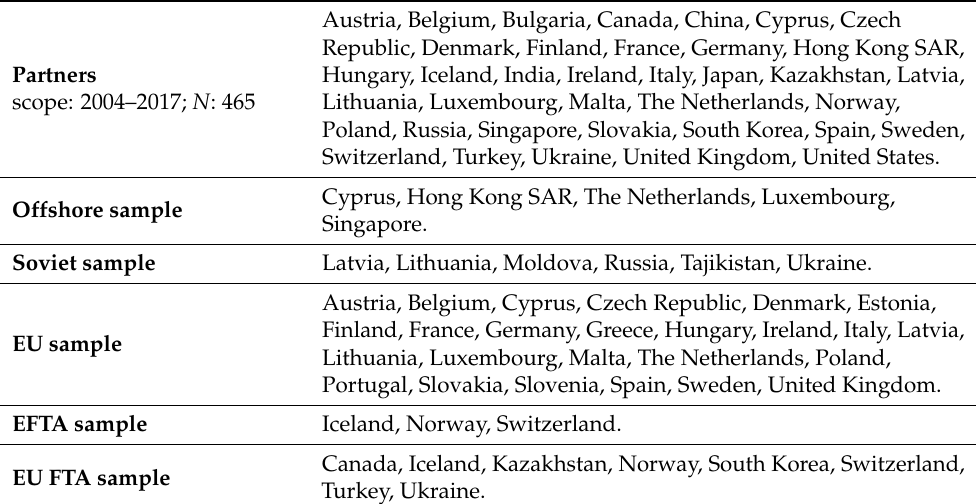
Table A2. List of inward FDI partners for